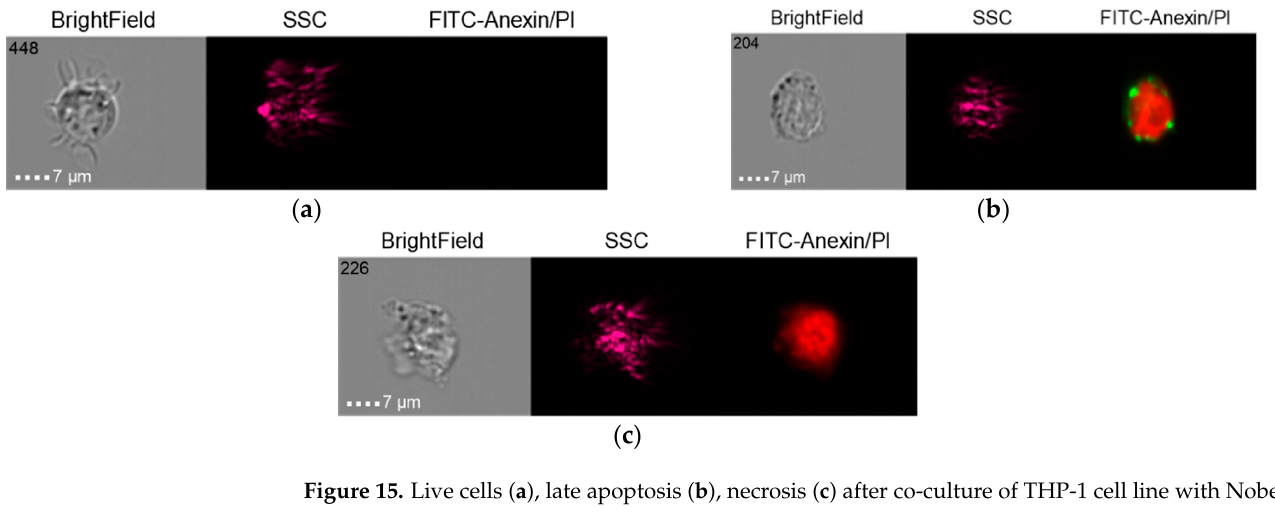
Figure 14. Live cells ( a ), early apoptosis ( b ), late apoptosis ( c ), necrosis ( d ) after co-culture of THP- 1 cell line with healthy donor serum without previous dental implantation (HDS + THP-1).